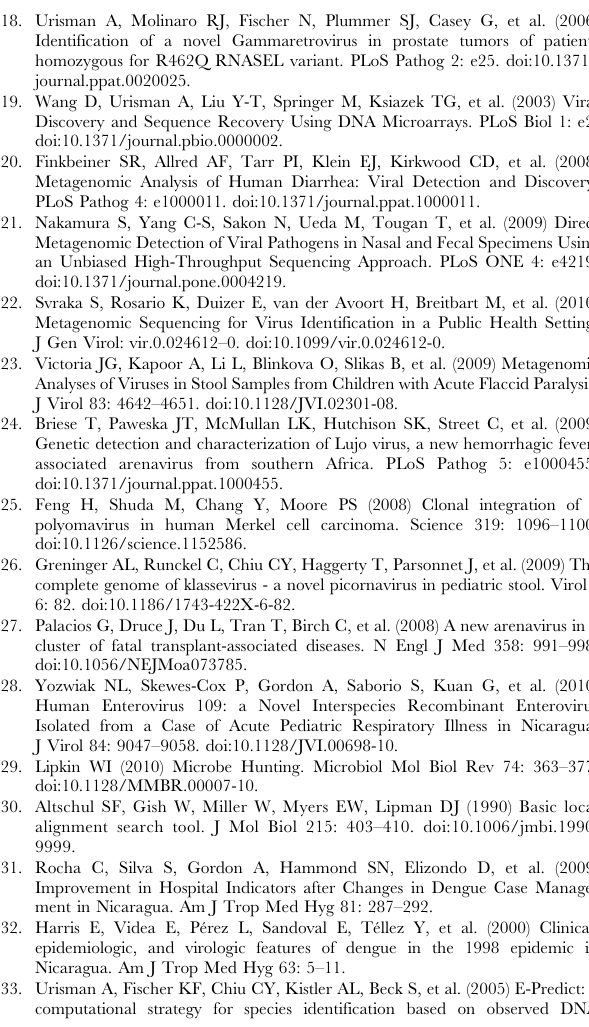
cleotides used in this